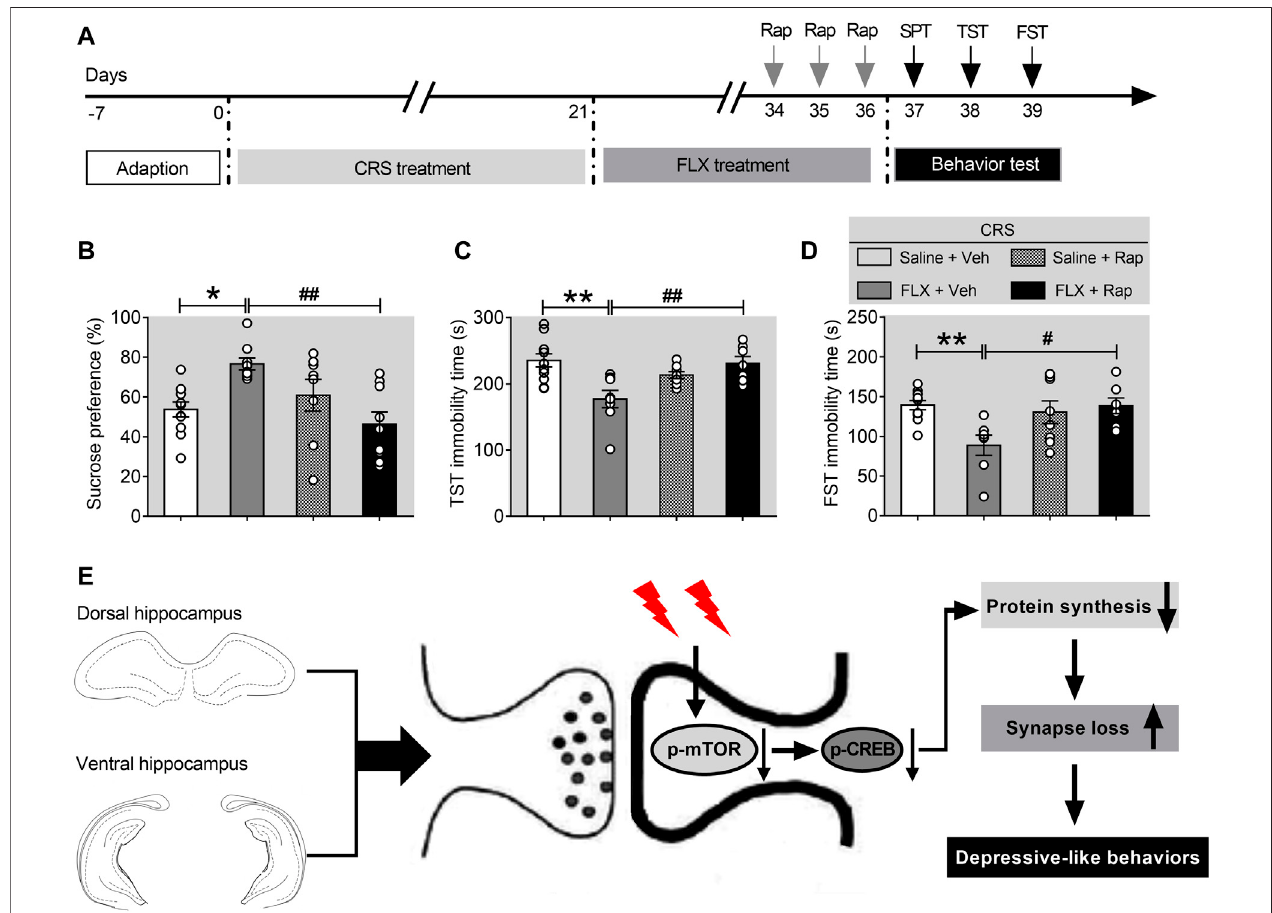
FIGURE 6 | Rapamycin abolishes the effects of fl uoxetine in chronically stressed mice. (A) The schematic timeline of the experimental procedures. (B – D) The antidepressant action of fl uoxetine was abolished by rapamycin, including reduced sucrose preference in the SPT (B) , increased immobile time in the TST (C) , and increased fl oating time in the FST (D) . (E) Schematic model for the role of mTORC1 signaling pathway in mediating synapse loss induced by chronic stress. CRS suppresses the mTORC1 signaling, followed by decreased phosphorylation levels of mTORC1 signaling-associated target proteins, which triggers the downregulation of protein synthesis and the synapse loss to contribute to depression-like behaviors. Data are presented as mean ± SEM. Two-way ANOVA for all. Respectively, n (cid:1) 11, 9, 9 and 9 per group for (B – D) . * p < 0.05, ** p < 0.01 vs. Saline + Veh group; # p < 0.05, ## p < 0.01 vs. FLX + Veh group.